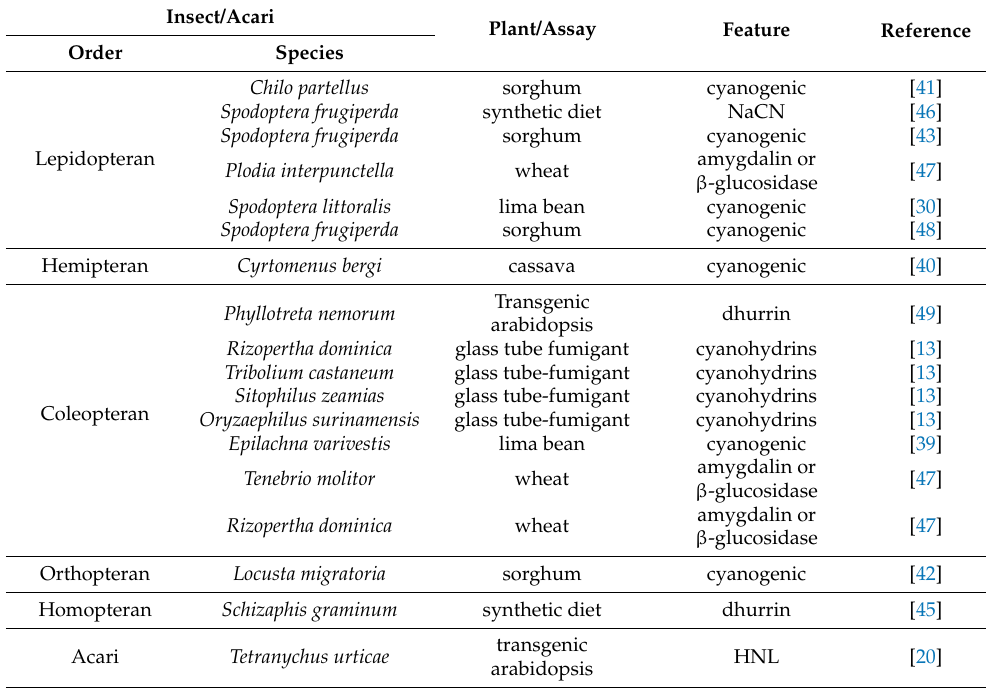
Table 1. Target phytophagous arthropods (insect or acari), plant or experimental assay and particular features (metabolite, enzyme or physiological characteristics) involved in cyanogenesis